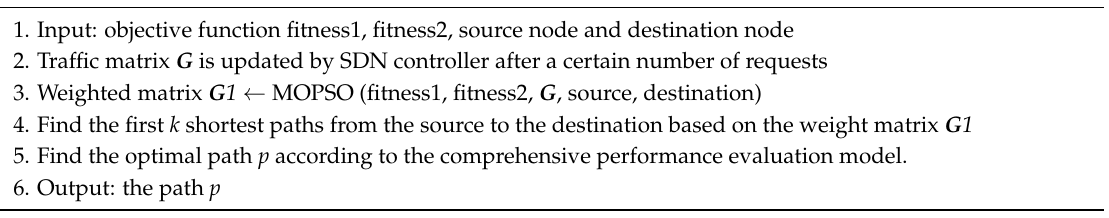
Algorithm 1: Find the optimal path p